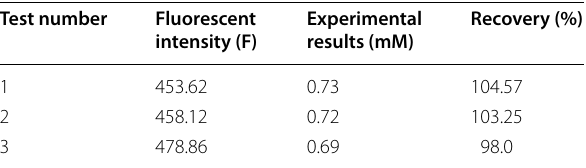
Table 2 The results from three independent experiments when the Fe 3 + with the concentration of 0.7 mM was added into the tap